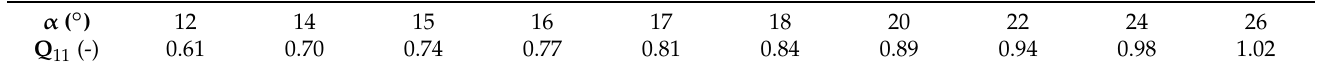
Table 1. Discharge factors Q 11 corresponding to the tested operating